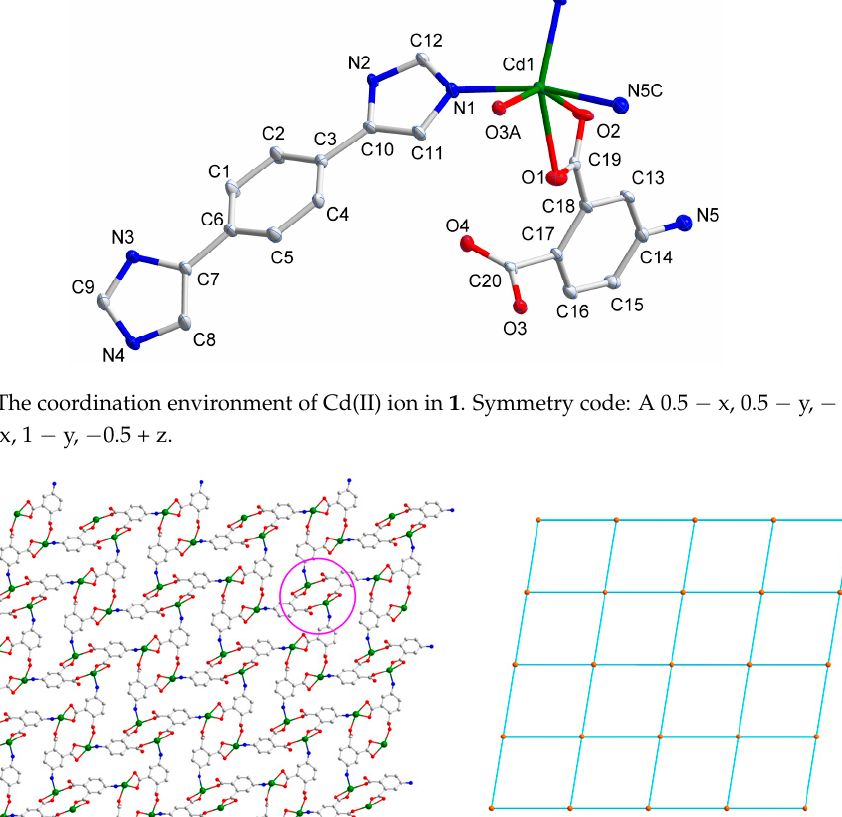
Figure 3. 2D framework of Cd(II)(H 2 L)(nobda) 2 − in 1 .